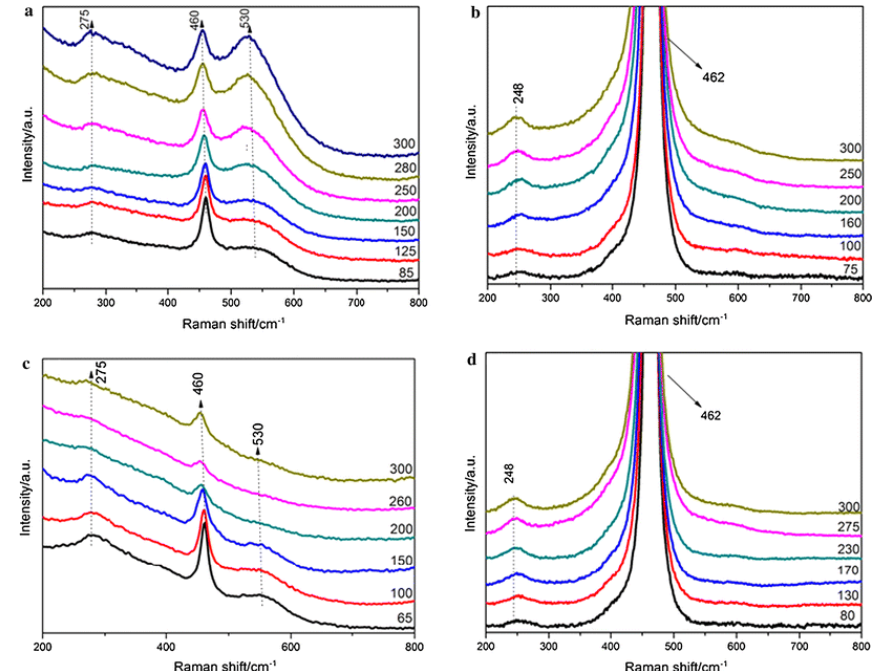
Figure 2. Raman spectra of different catalysts under different reaction conditions ( a ) Ag/CeO 2 —5 vol% CO/N 2 , ( b ) CeO 2 —5 vol% CO/N 2 , ( c ) Ag/CeO 2 –O 2 , ( d ) CeO 2 –O 2 . Reproduced from Ref. [72] with the permission from Springer.